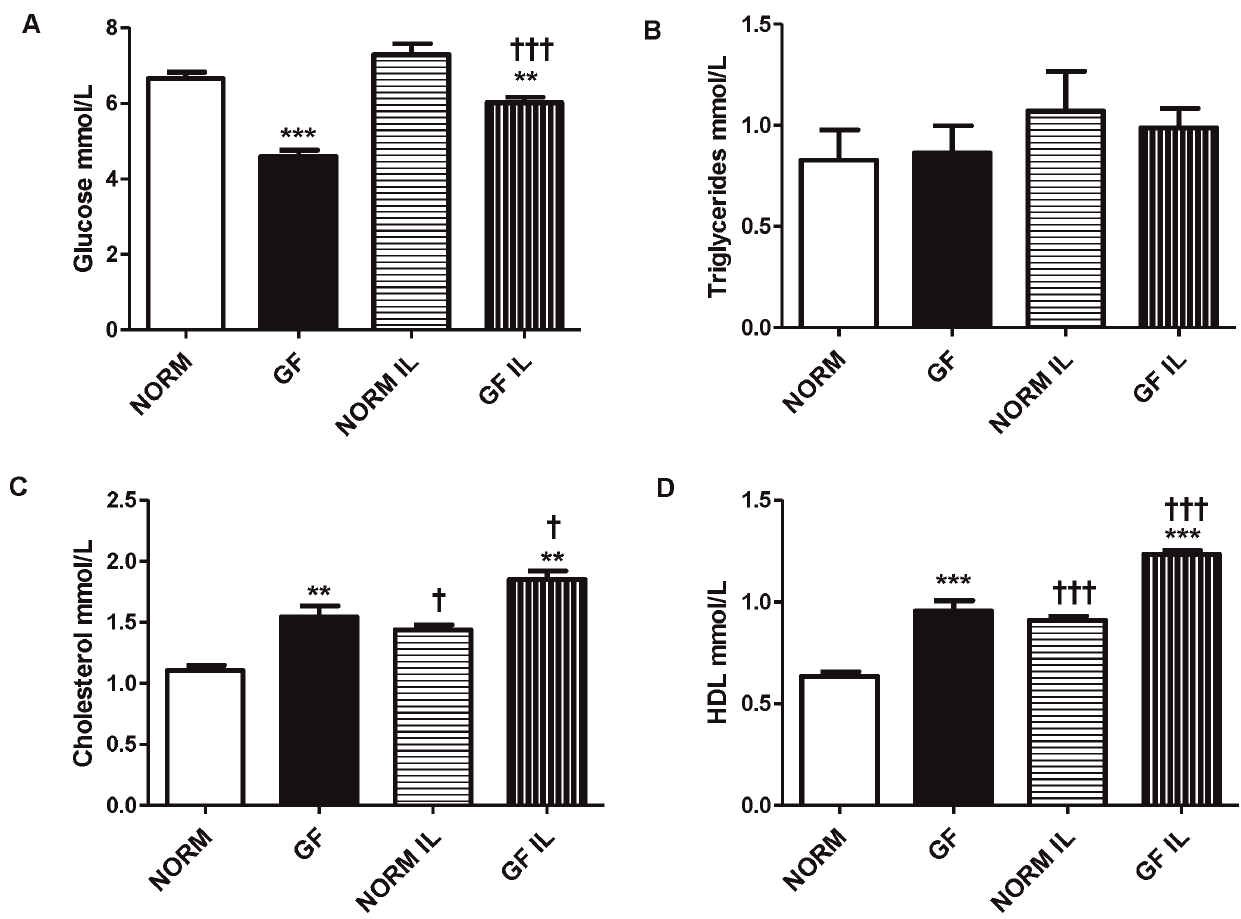
Figure 7. Plasma levels of (A) glucose, (B) total triglycerides, (C) cholesterol, and (D) HDL in GF and NORM mice following an overnight fast or re-feeding with 1-ml of 20% intralipid. (A) Plasma glucose levels of GF mice were lower than NORM controls and re-feeding increased glucose levels in GF, but not NORM mice. (B) Plasma triglycerides were similar between both groups and feeding conditions. (C) Plasma total cholesterol was increased in GF mice relative to NORM controls and re-feeding increased cholesterol levels in both NORM and GF mice. (D) Total plasma HDL was increased in GF mice relative to NORM mice with re-feeding increasing total HDL in both groups. Data are expressed as means 6 SEM. **P , 0.01 mice, ***P , 0.001 compared to NORM. { P , 0.05, {{ P , 0.01, compared to fasting condition within